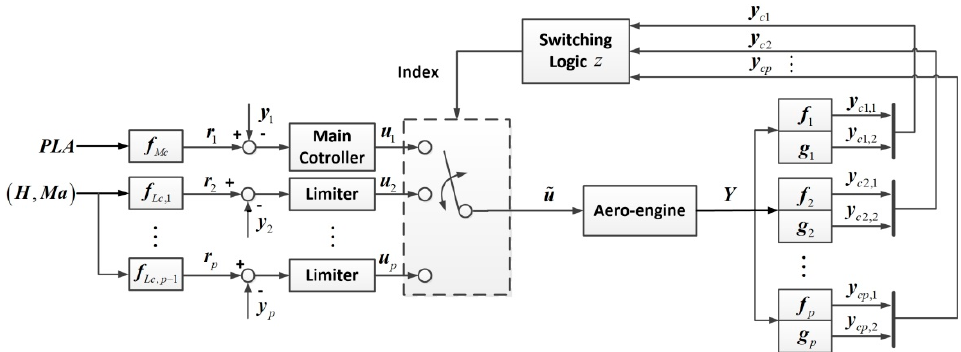
Figure 3. Output-based multi-loop switching control strategy.